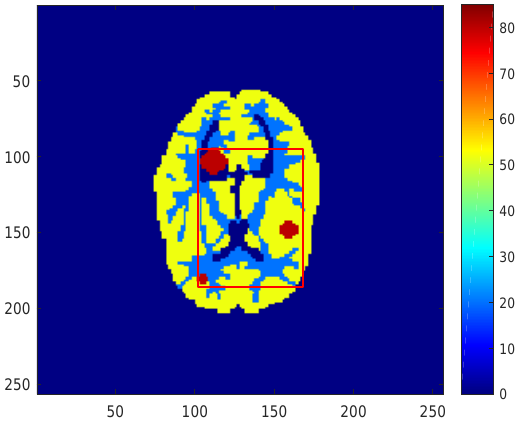
Figure 3. The Hoffman brain phantom, composed of gray matter, white matter, and three